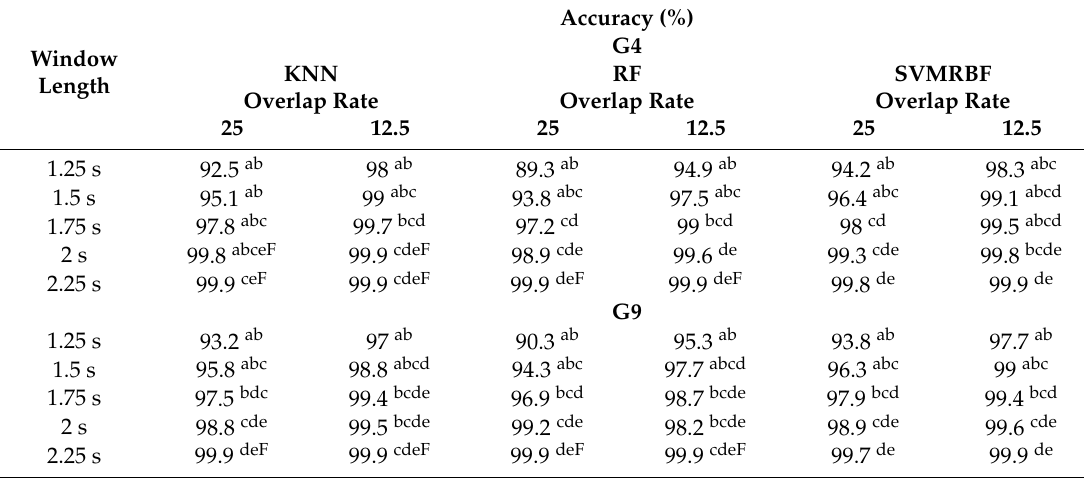
a,b,c,d,e Equivalent statistical distribution for each window length in its respective column (same overlap rate) from Tukey post-hoc from Friedman test ( p > 0.05): 1.25 (a), 1.5 (b), 1.75 (c), 2 (d), and 2.25 (e) seconds. F Equivalent statistical distribution for each 25 and 12.5 overlap rate pair in its respective row according to Wilcoxon test ( p >